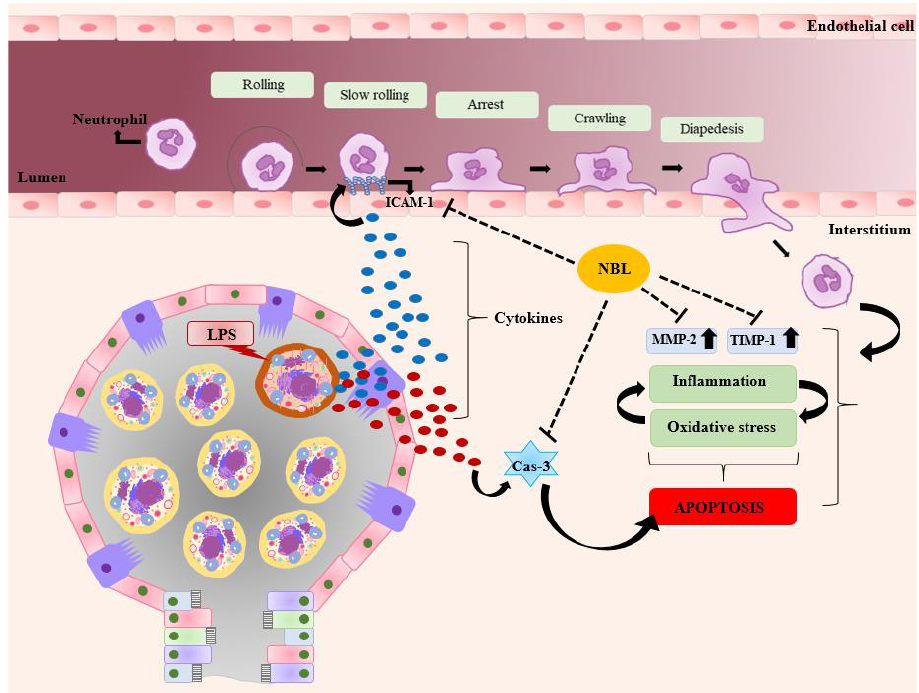
Figure 6. The possible effect of NBL on the pathophysiological mechanisms of LPS-induced lung injury; Cas-3: Caspase-3, ICAM-1: Intercellular Adhesion Molecule-1, LPS: Lipopolysaccharide, MMP-2: Matrix Metallo-proteinase-2, TIMP-1: Tissue inhibitor of metalloproteinase NBL: Nebivolol.